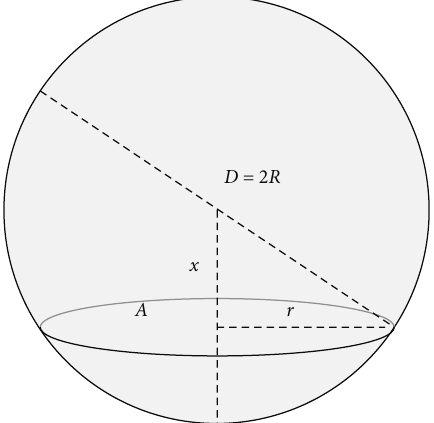
Figure 2: Method of converting 2D area measured from SEM image to 3D diameter of a foam cell in a RPU